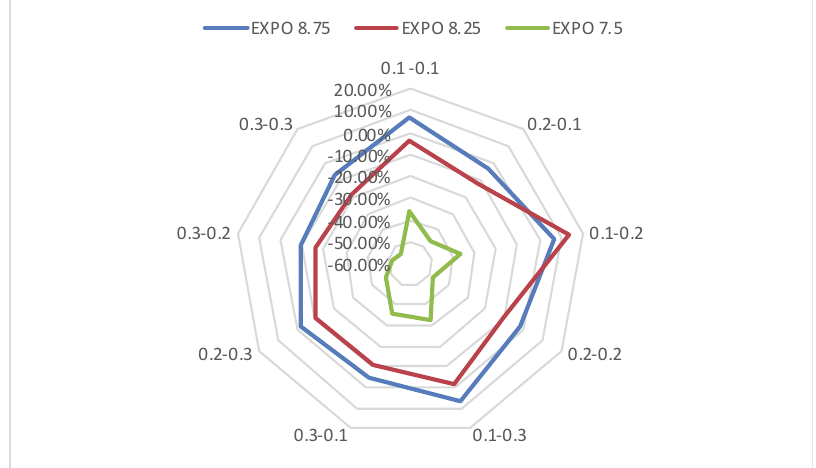
Fig. 7. Average Throughput